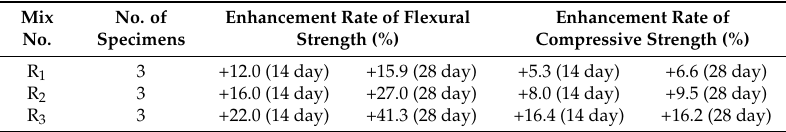
Table 4. Enhancement of flexural and compressive strengths compared with R 0 .